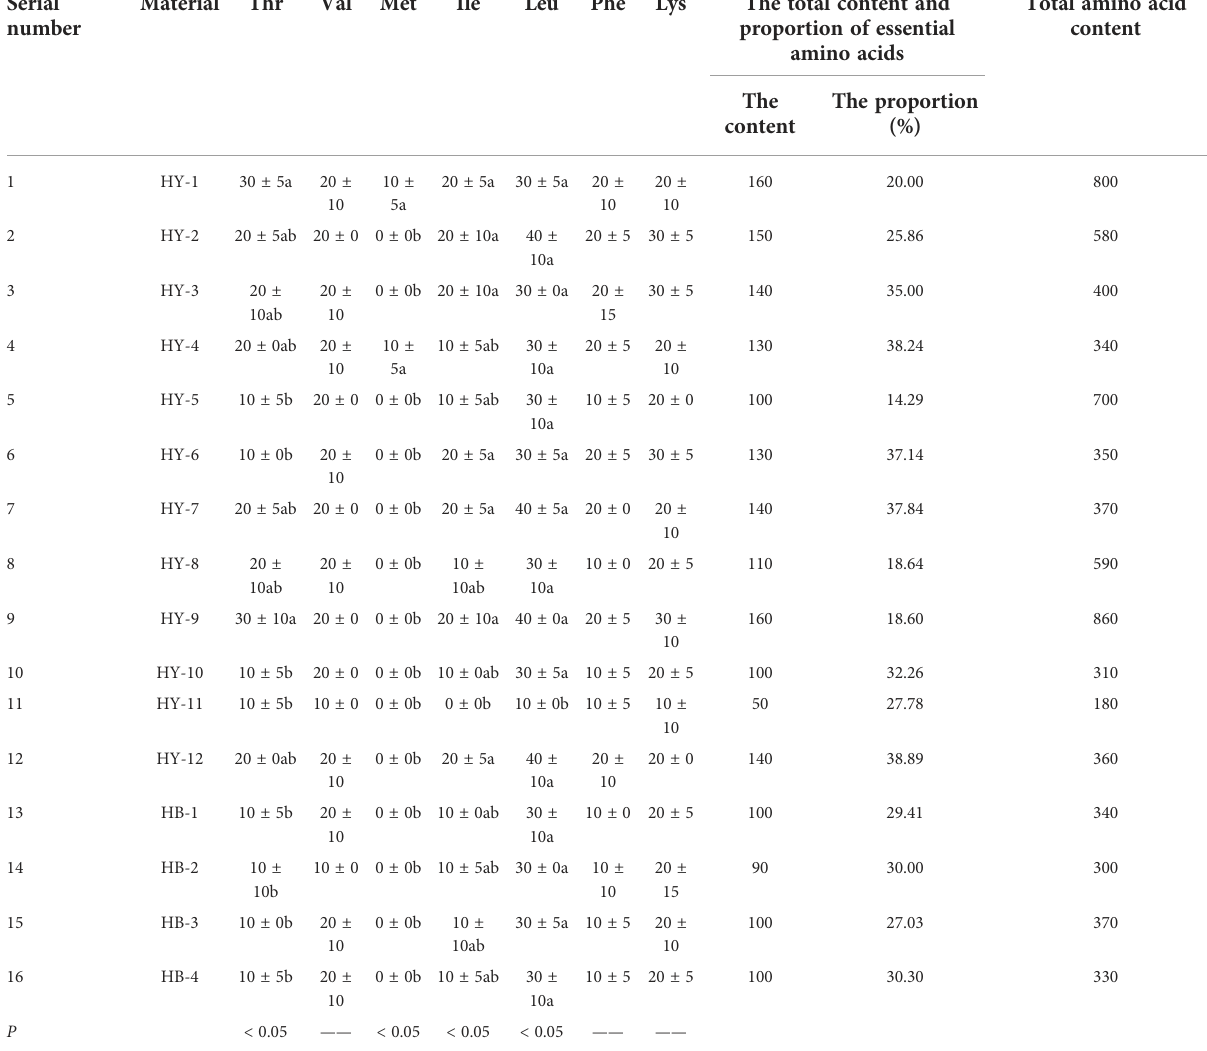
TABLE 4 The content of essential amino acids in the pulp of different genotypes of A. trifoliata fruit(mg/100g). Serial